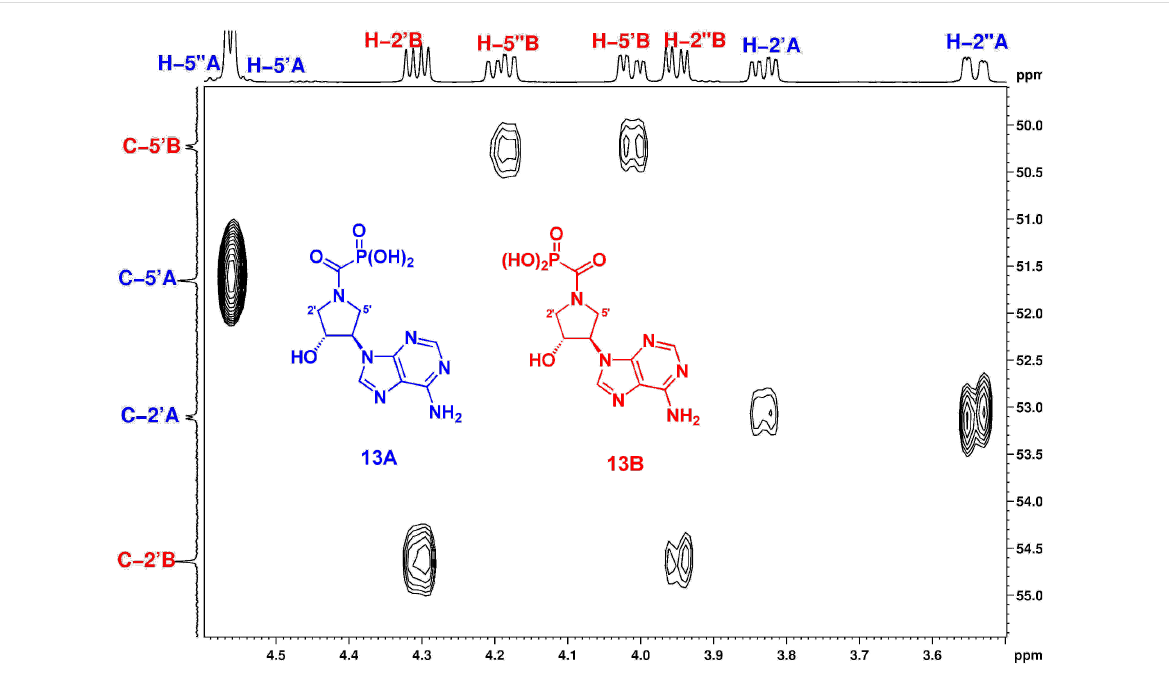
Figure 10: A part of the H,C-HSQC spectrum of derivative 13 , showing the assignment of rotamers A and B.